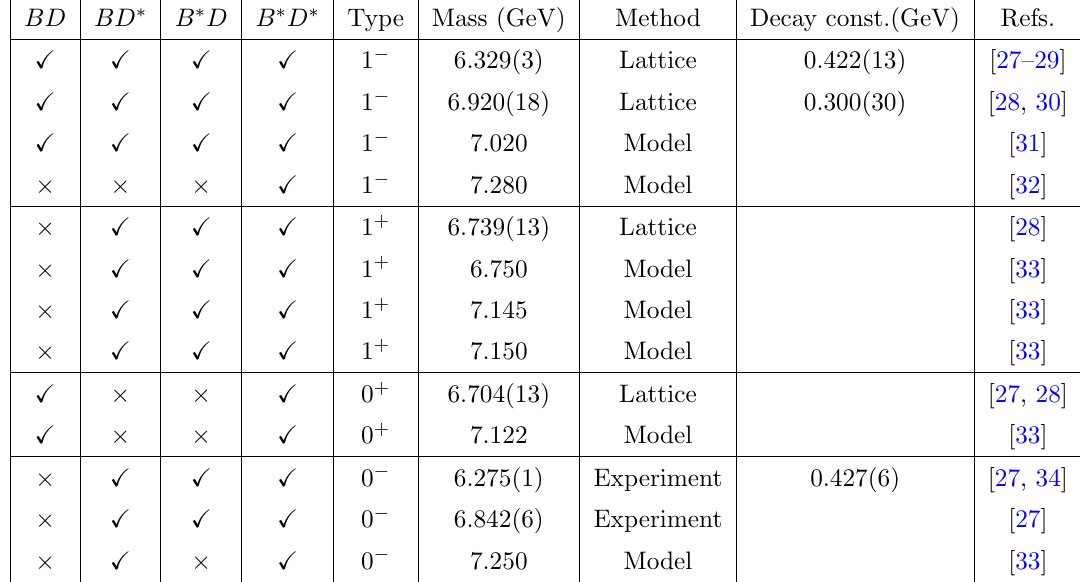
Table 3 . Relevant B ( (cid:3) ) c masses and decay constants, consistent with the subsets used in refs. [5,